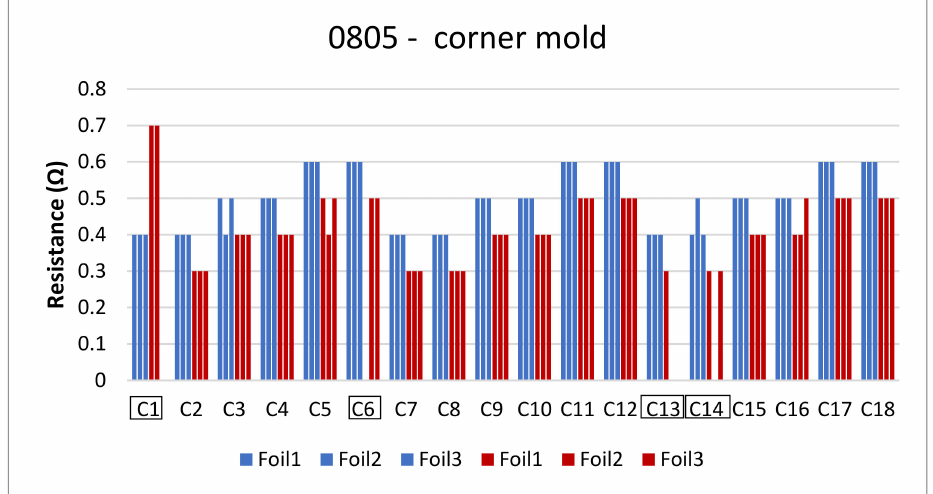
Figure 25. Resistance measurements for 0805 resistors molded in corner mold.